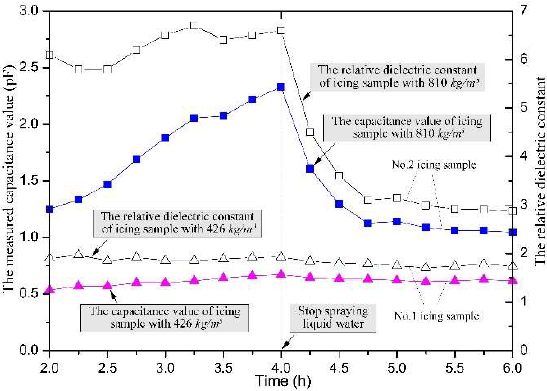
Figure 7. The relative dielectric constant curve of the two icing samples.